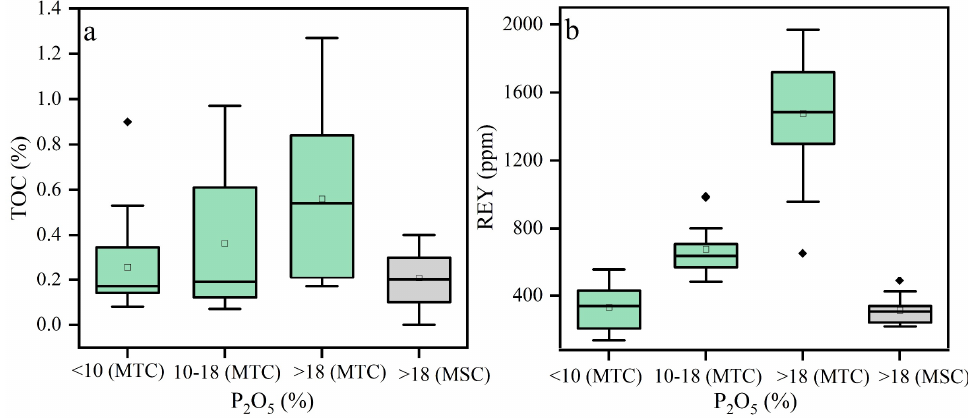
Figure 9. Box plots of TOC and REY concentrations. ( a ) The box plot between phosphorus rock series and TOC, ( b ) The box plot between phosphorus rock series and REY. Meishucun (MSC) data were obtained from [37].